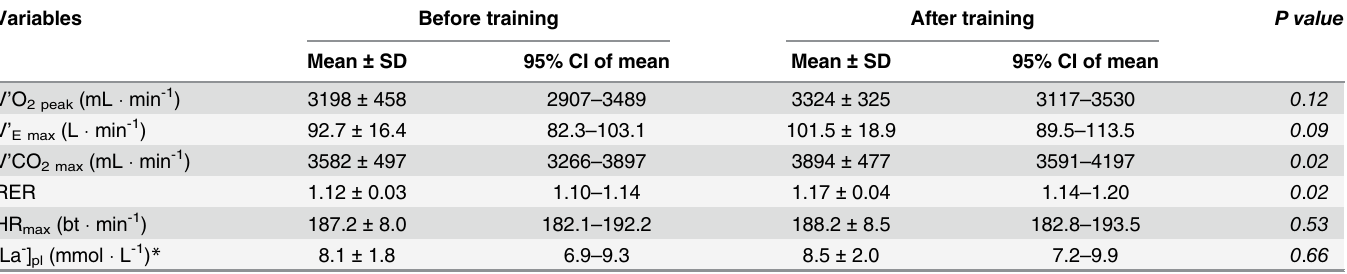
Table 1. Values of peak power output, selected cardio-respiratory variables and plasma lactate concentration obtained at exhaustion during the incremental exercise test performed before and after 20 weeks of endurance training. Variables